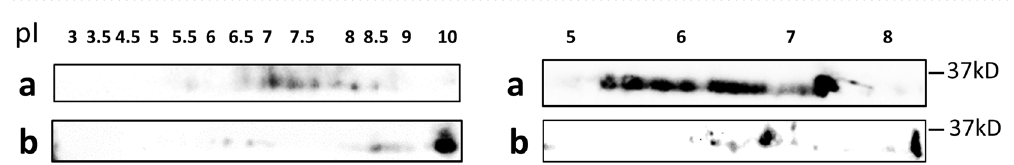
Figure 3. Predicted phosphosites in IDRs of the gNACβ subunits. Docking sites for various Ser-Thr protein kinases (CK1, CK2, NEK2, LATS, ProDKin, PIK and GSK3-Ser) are indicated; X-linked paralogs of D. melanogaster (Flybase.org, ELM Database 33,34 , α-helices and β-sheet regions are designated with red bars and green arrows, respectively.